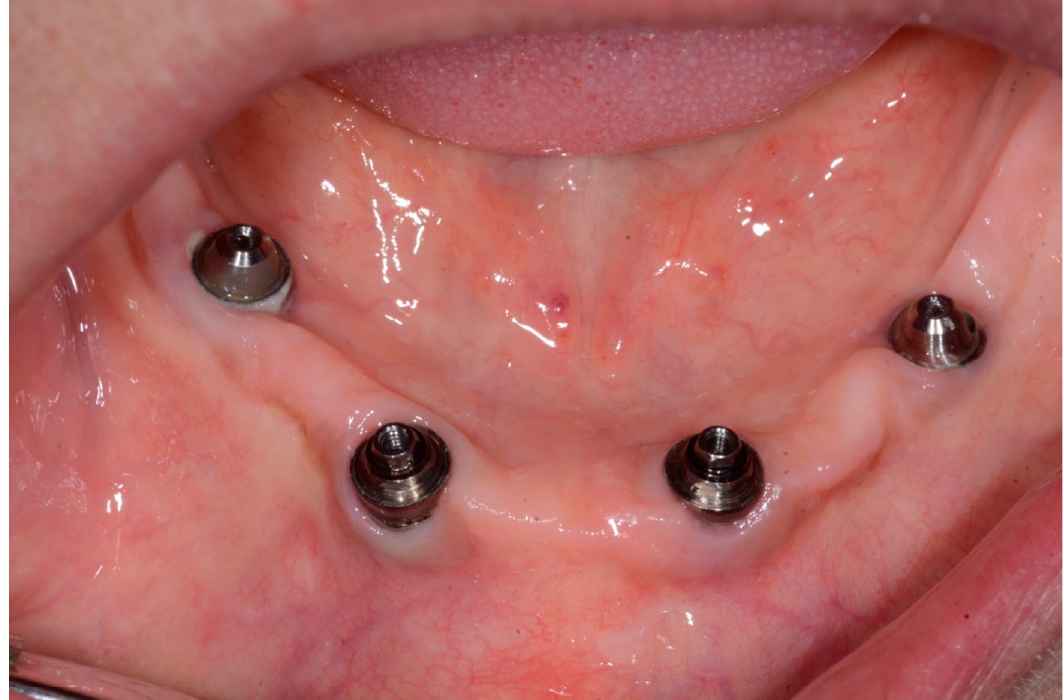
Figure 4. Condition of soft tissues around dental implants in positions 3.2 and 4.2 in 6 months after treatment.